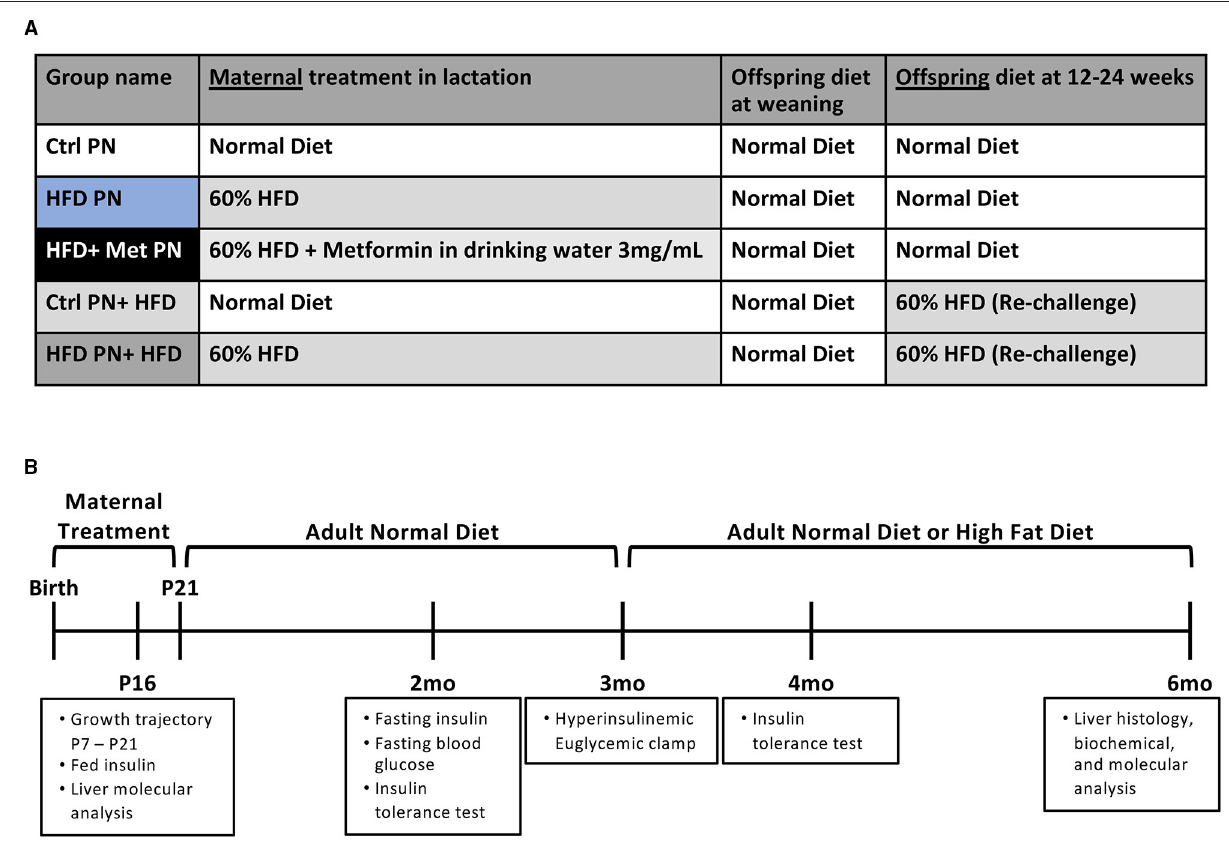
FIGURE 1 | Experimental schema for the experiments presented. (A) A scheme of diet conditions per group. (B) Experimental timeline. Ctrl, control; HFD, high-fat diet; PN, post-natal; Met,